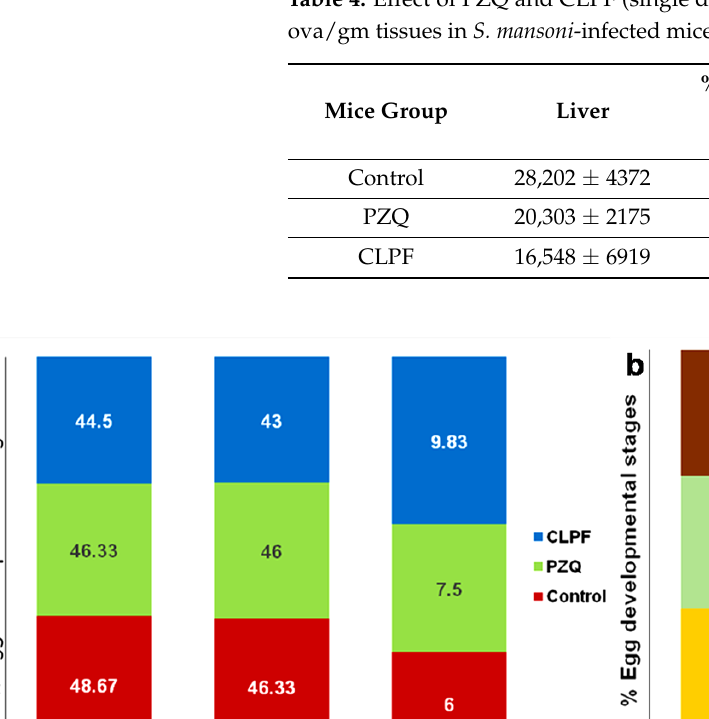
Table 3. Effect of PZQ and CLPF (single dose 250 mg/kg two weeks post-infection) on worm loadand their sex in S. mansoni -infected mice euthanized six weeks post-infection.